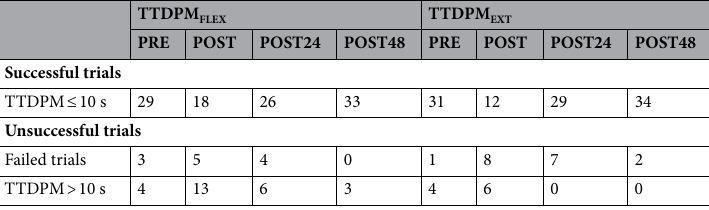
Table 2. Number of successful and unsuccessful trials during movement sense evaluations at each time point. TTDPM Threshold To Detect Passive Movement, TTDPM FLEX Threshold To Detect Passive Movement into flexion at 30° of knee flexion, TTDPM EXT Threshold To Detect Passive Movement into extension at 30° of knee flexion , Failed trials trials where participants pressed the button while no movement was generated.